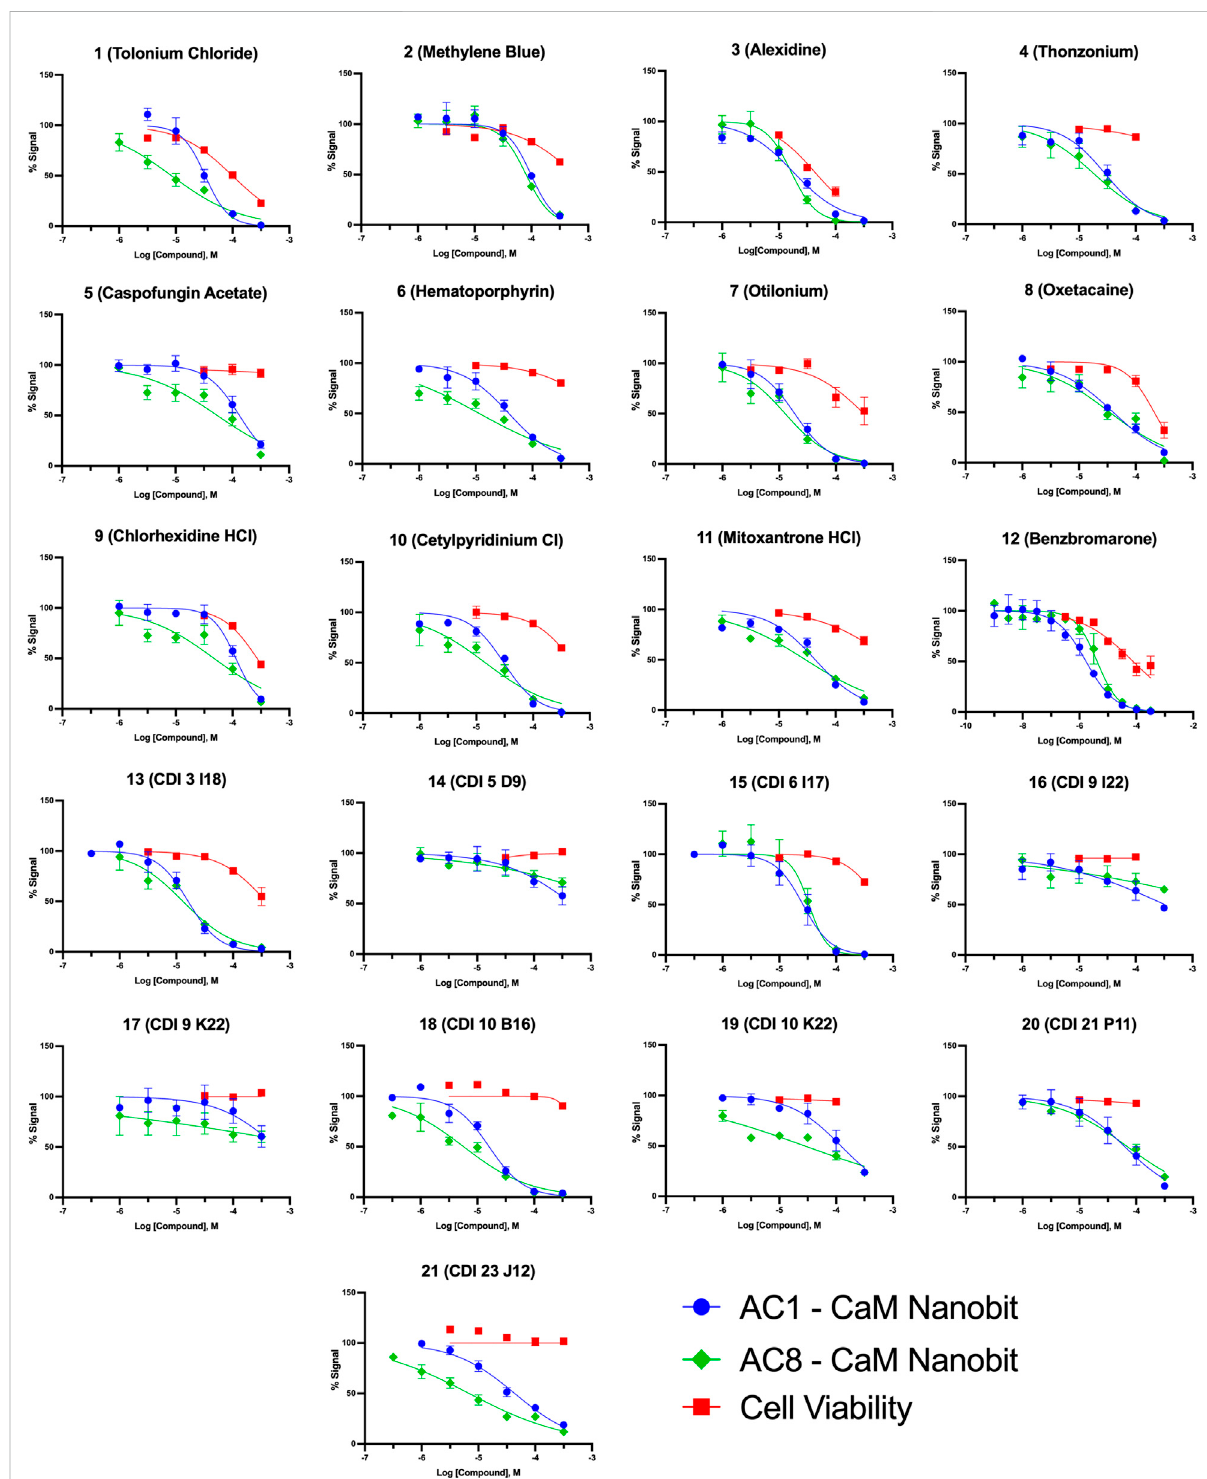
FIGURE 5 Concentration response curves for AC1/CaM pilot screen hits in NanoBiT assay and CellTiter Glo-2.0 cell viability assay. NanoBiT results are shown as blue circles for AC1/CaM, green squares for AC8/CaM, and red squares for cell viability (CellTiter Glo-2.0) assay results. The baseline corrected AUC values are normalized to vehicle in the presence of thapsigargin (100%) or vehicle pre-treated with BAPTA-AM (0%) for the NanoBiT assay. The cell viability data is normalized to the cells treated with vehicle (100%) or cell free wells with vehicle added (0%). Data represents n = 3 experiments